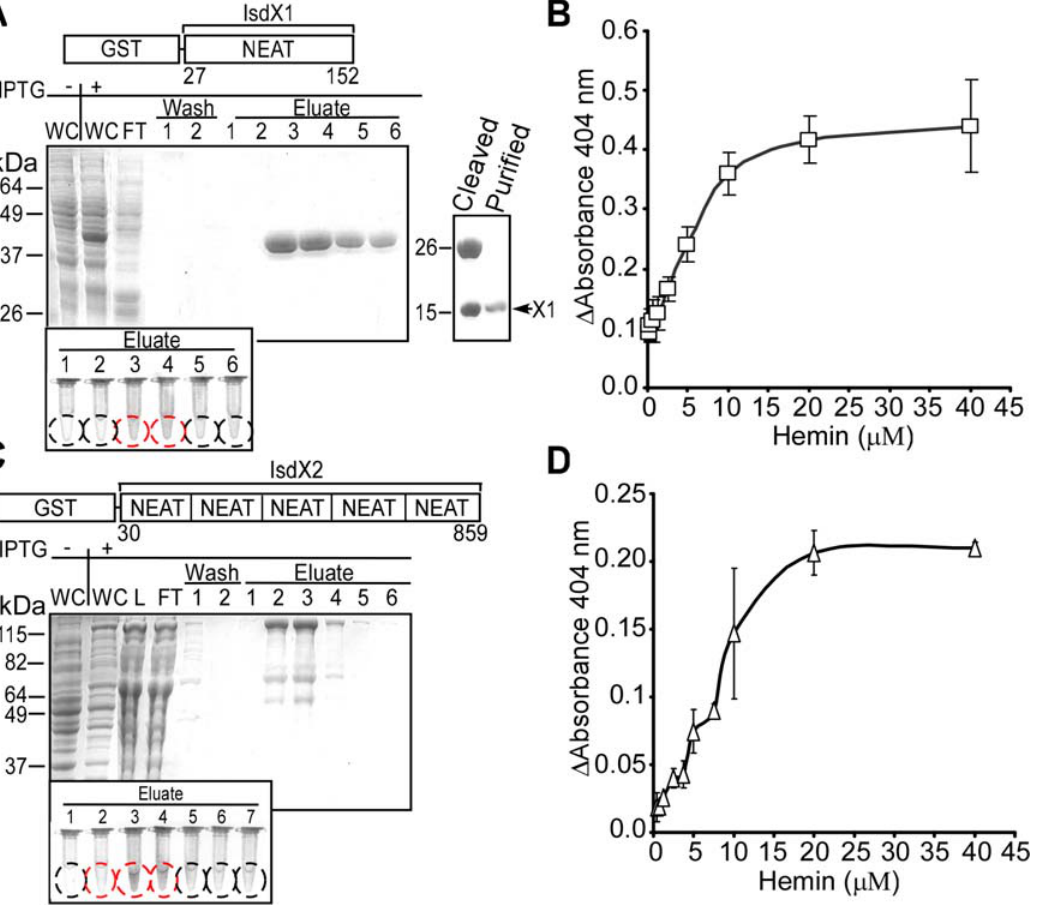
Figure 3. IsdX1 binds heme. ( A and C ) Codons 27–152 of isdX1 and 30–859 of isdX2 were cloned into pGEX-2TK and the hybrid GST-fusions purified by affinity chromatography. Whole cells (WC), flow through (FT), wash and eluate fractions were analyzed on Coomassie-stained SDS-PAGE. The arrow in A identifies IsdX1, where GST had been removed with thrombin. The insets display tubes with eluate fractions (circled) containing red- brown pigment indicative of iron-porphyrin binding (red circles). ( B and D ) IsdX1 (20 m M) or IsdX2 (1 m M) were incubated with hemin and absorbance at 404 nm measured. Mean and standard deviation of three independent experiments were recorded.